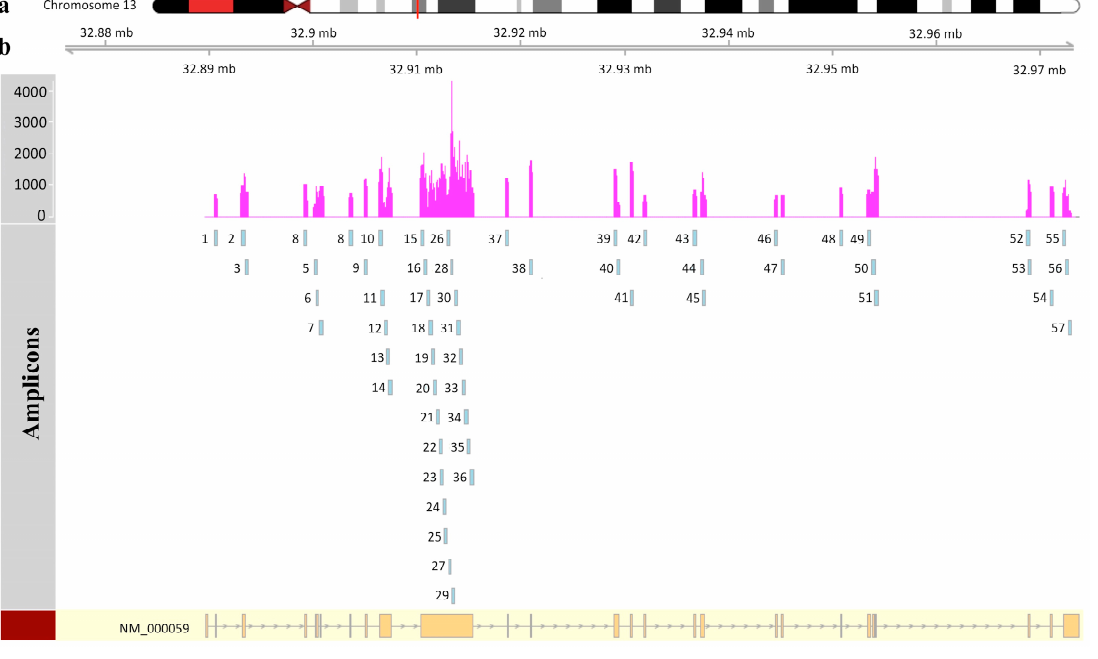
Figure 1. Next generation sequencing coverage of the BRCA2 gene. ( a ) The relative position of the BRCA2 gene on chromosome 13. ( b ) The patient’s coverage for each sequenced amplicon is reported with respect to BRCA2 exons at the bottom.